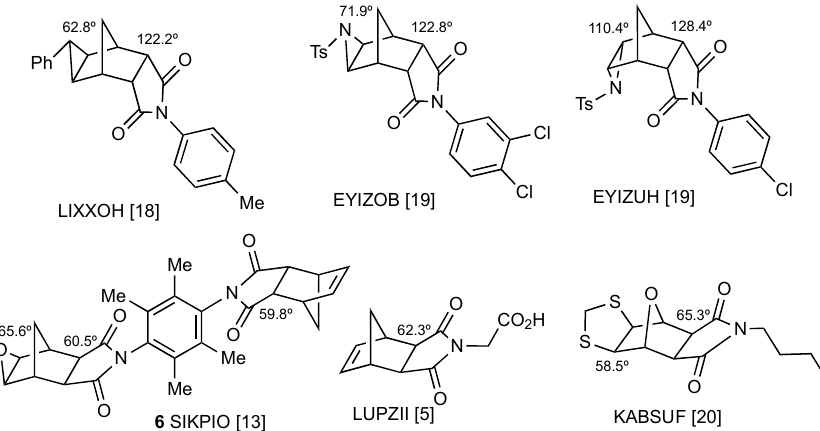
Figure 3. Similar crystallographically characterised compounds with inter-ring angles. Although cyclic NH imides show a wide variety of intermolecular hydrogen bonding patterns in the crystalline state [21], this relies on having a free NH present and, as might be expected, there are no strong intermolecular interactions between molecules of 3 in the crys- tal. A view of the unit cell does however show the molecules arranged with hydrophobic butyl groups in a layer between the more polar epoxy imide moieties (Figure 4).